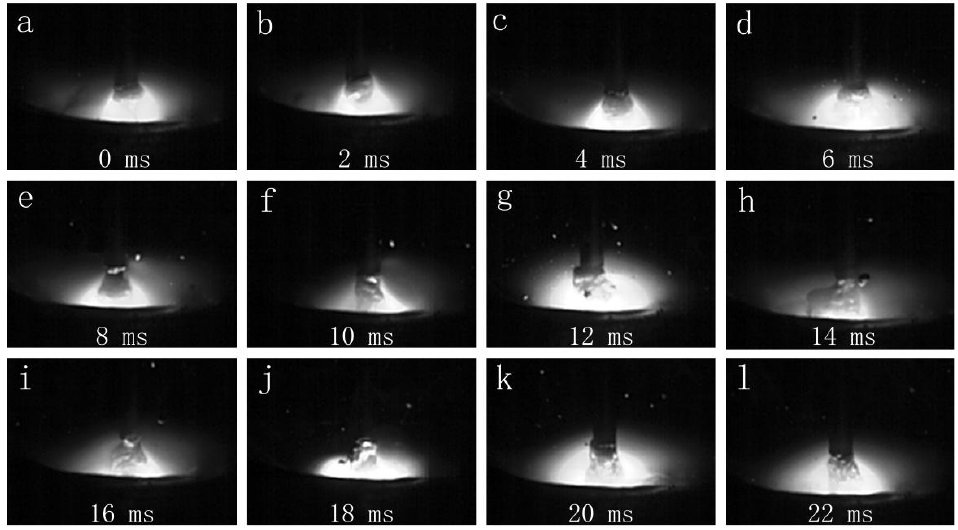
Figure 3. The droplet transfer process of MIG mode (7150 filler wire): ( a – l ) show the droplet transfer process in chronological order.